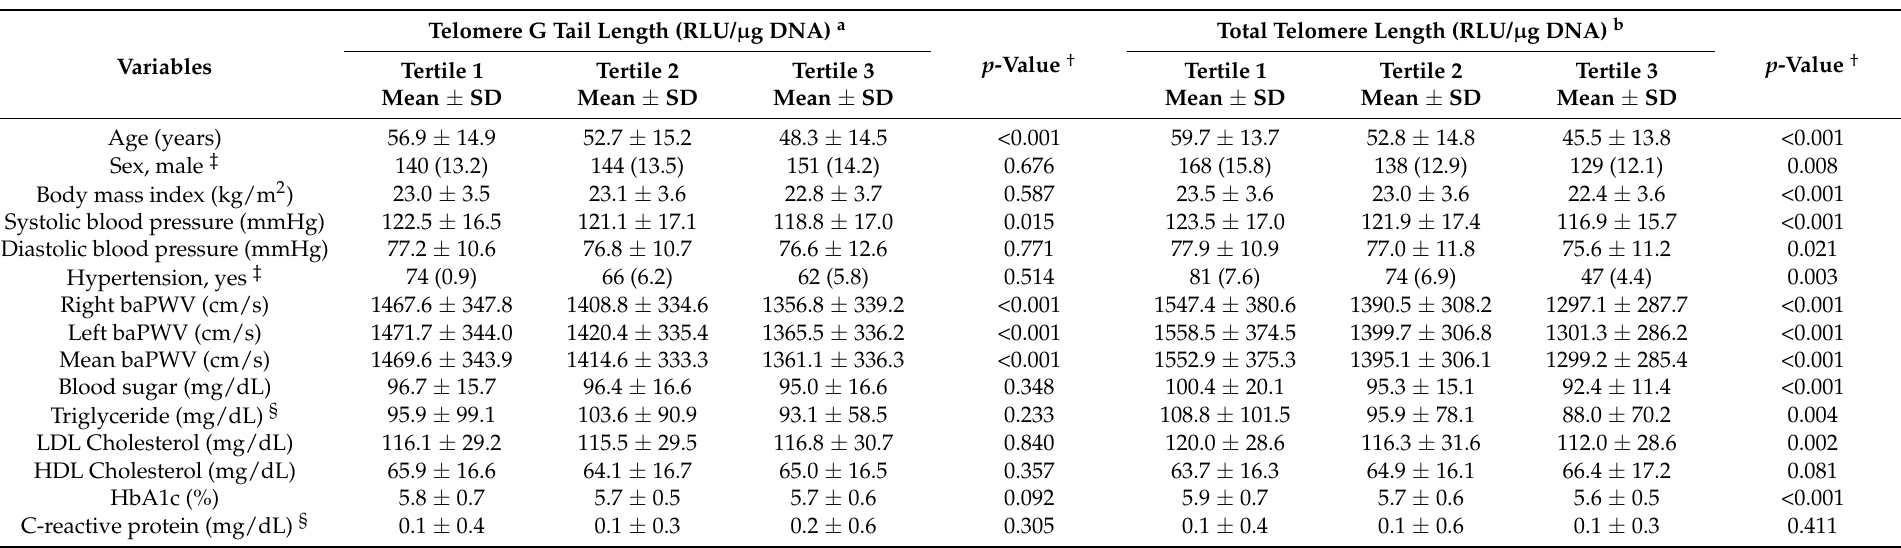
Table 3. Characteristics according to telomere G-tail length tertiles and total telomere length tertiles ( n =